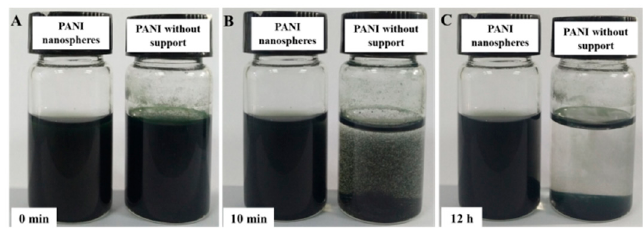
Figure 2. Photographs of aqueous PANI and pristine polyaniline dispersion (15 mL, 0.2 mg/mL): as